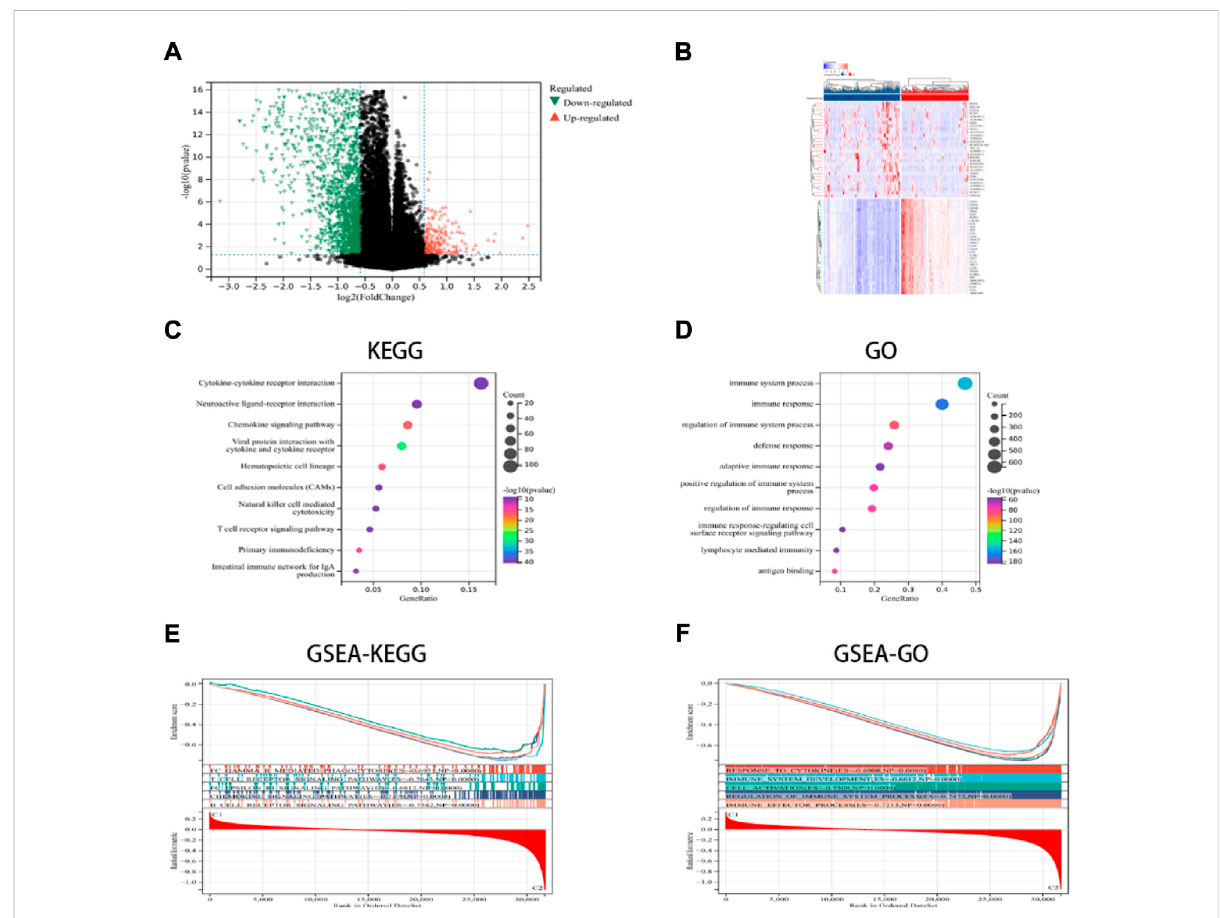
FIGURE 2 DEGsandassociatedsignalingpathwaysareidenti fi ed. (A) ThedistributionoftheDEGsbetweentheICD-lowandICD-highsubcategoriesinthe TCGA dataset; (B) The expression of DEGs in various subgroups; and (C,D) the GO and KEGG enrichment analyses of signaling pathways; (E,F) The GSEA identi fi es the fundamental signal pathways present in both the ICD